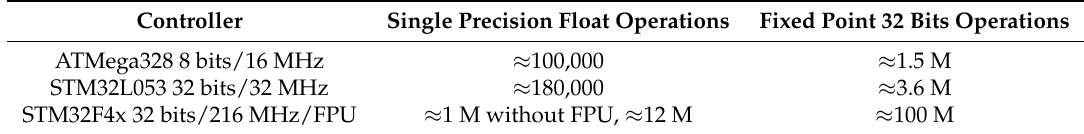
Table 6. Computing